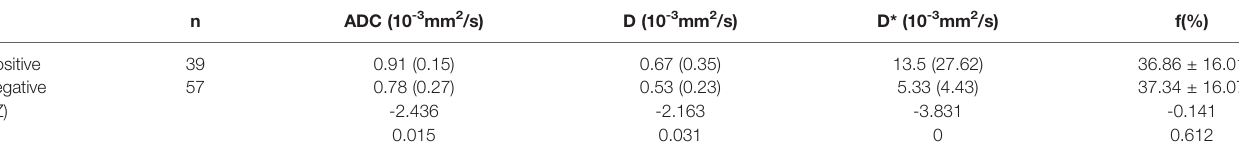
TABLE 1 | Statistical results of IVIM-DWI parameters between the EMVI positive group and the EMVI negative group of rectal adenocarcinoma. n ADC (10 -3 mm 2